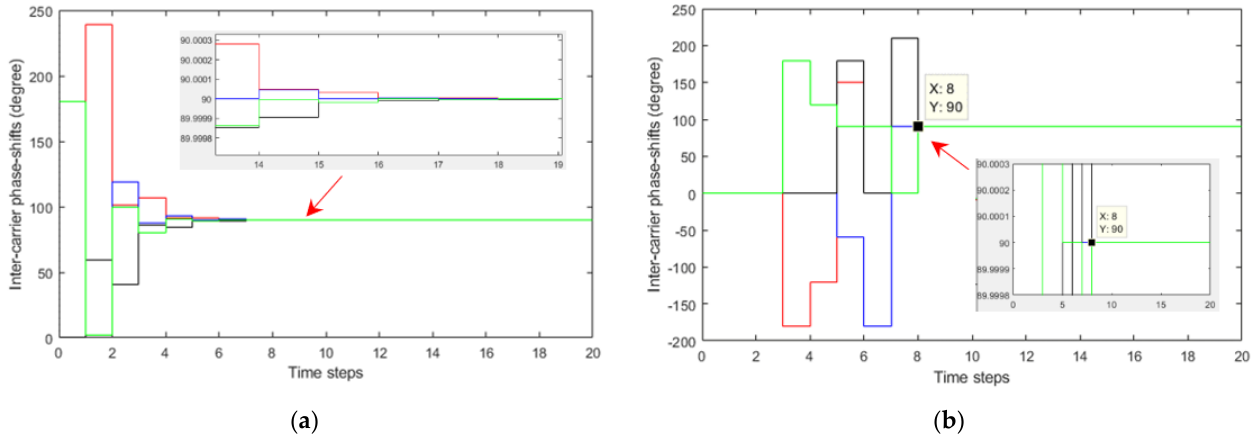
Figure 23. The inter-carrier phase-shifts of a converter with four-carriers, startup with ( a ) conventional modified updating rule; ( b ) proposed DSA-PSC.